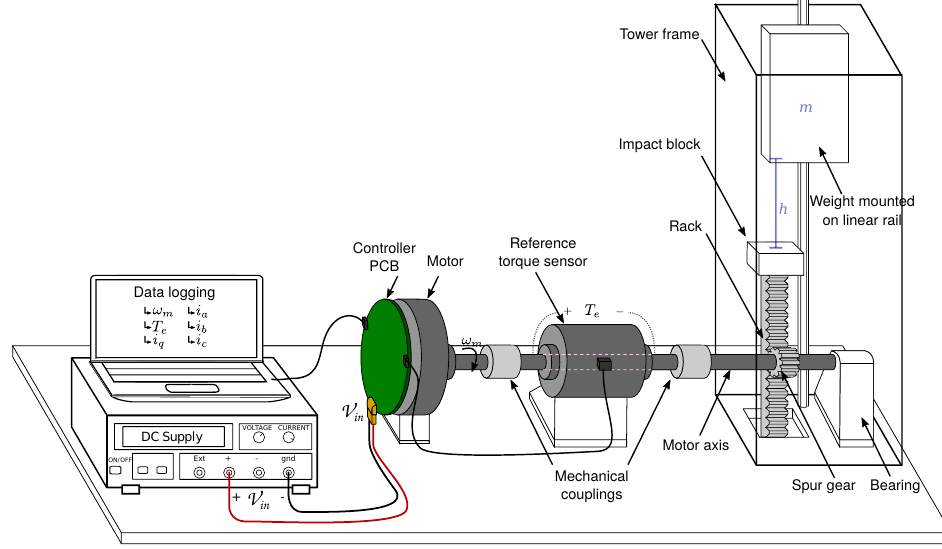
Figure A3. Illustration of the test configuration used for testing the motor controller during impact